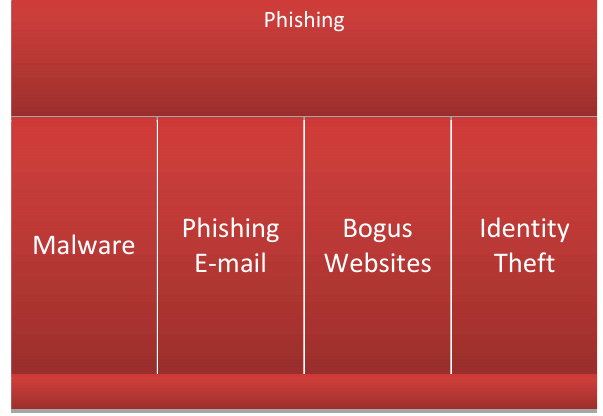
Figure 4-2: Phishing